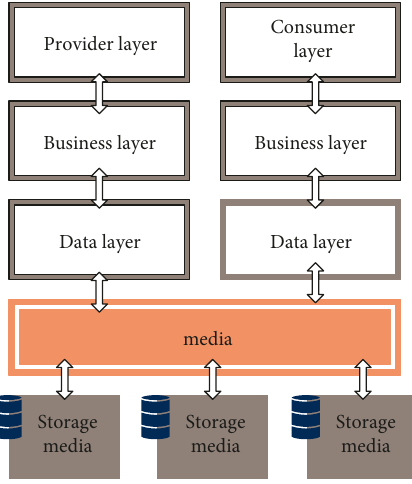
Figure 3: The overall